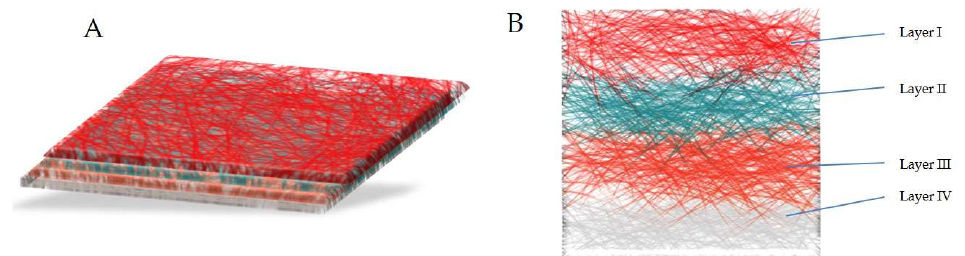
Figure 5. Graphical presentation of multi-drug delivery system: ( A ) overview; ( B ) cross sectional view of a tetra-layered sequential electrospun mesh. Cross-sectional view consists of drug loaded mesh (layer I), barrier mesh (layer II), second drug loaded mesh (layer III) and basement mesh (layer IV). Redrawn from [102] .